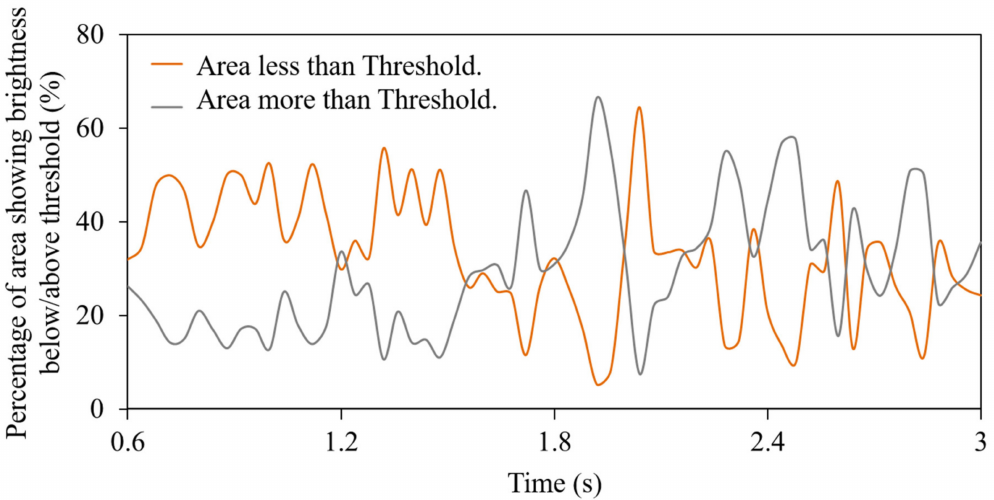
Figure 14. Comparison of the average brightness change curves with time, calculated based on dark area and bright area (CFRP 5 wt %, BP = 4 MPa, 60 rpm, Shot No.